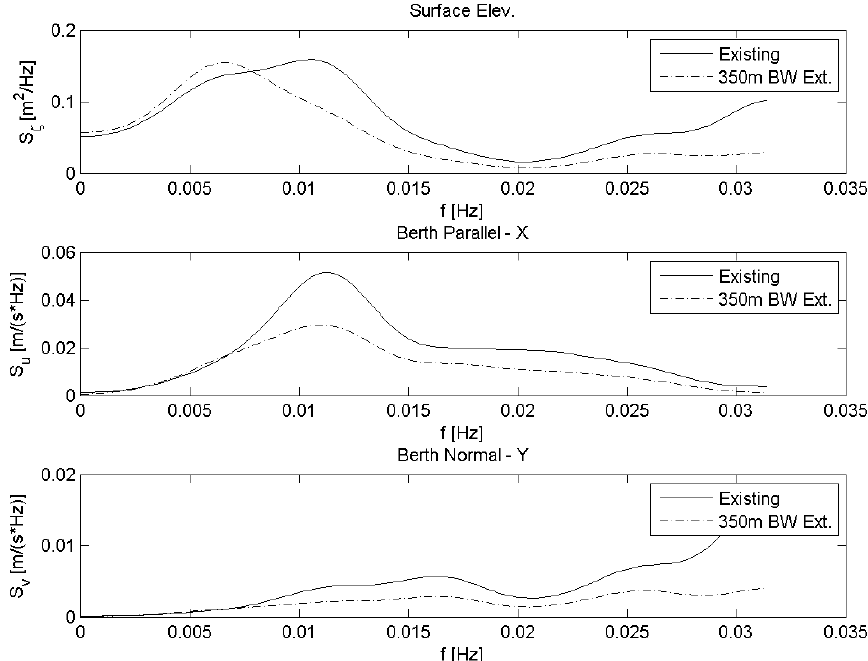
Figure 10. Surface elevation ( top ), Berth Parallel ( X ) current ( middle ) and Berth Normal ( Y ) current frequency spectra for existing and 350 m breakwater cases at middle of Berth 5 — Event 1.